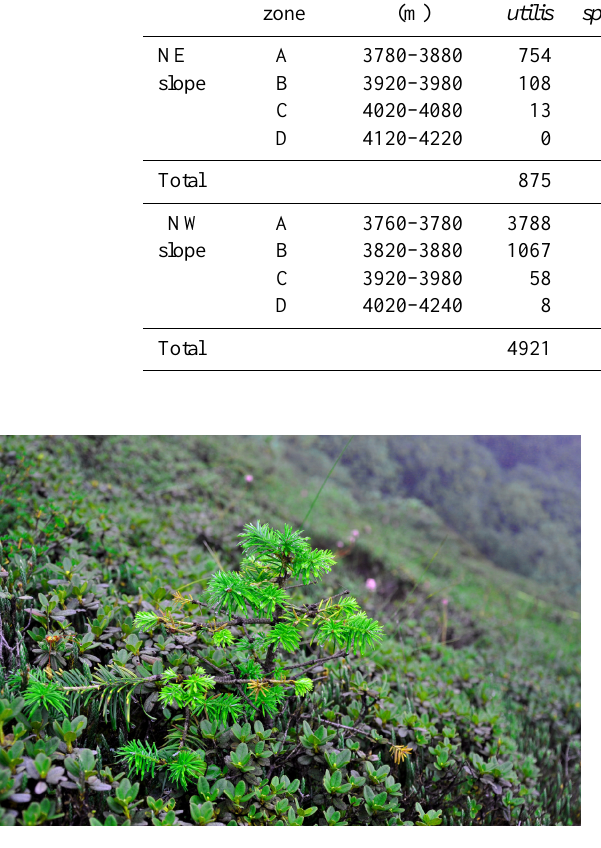
Figure 7. Abies spectabilis sapling at 4200m in Rhododendron an- thopogon dwarf scrub heath, Rolwaling, Nepal, ca. 200m above treeline (Schickhoff, 20 August 2013).